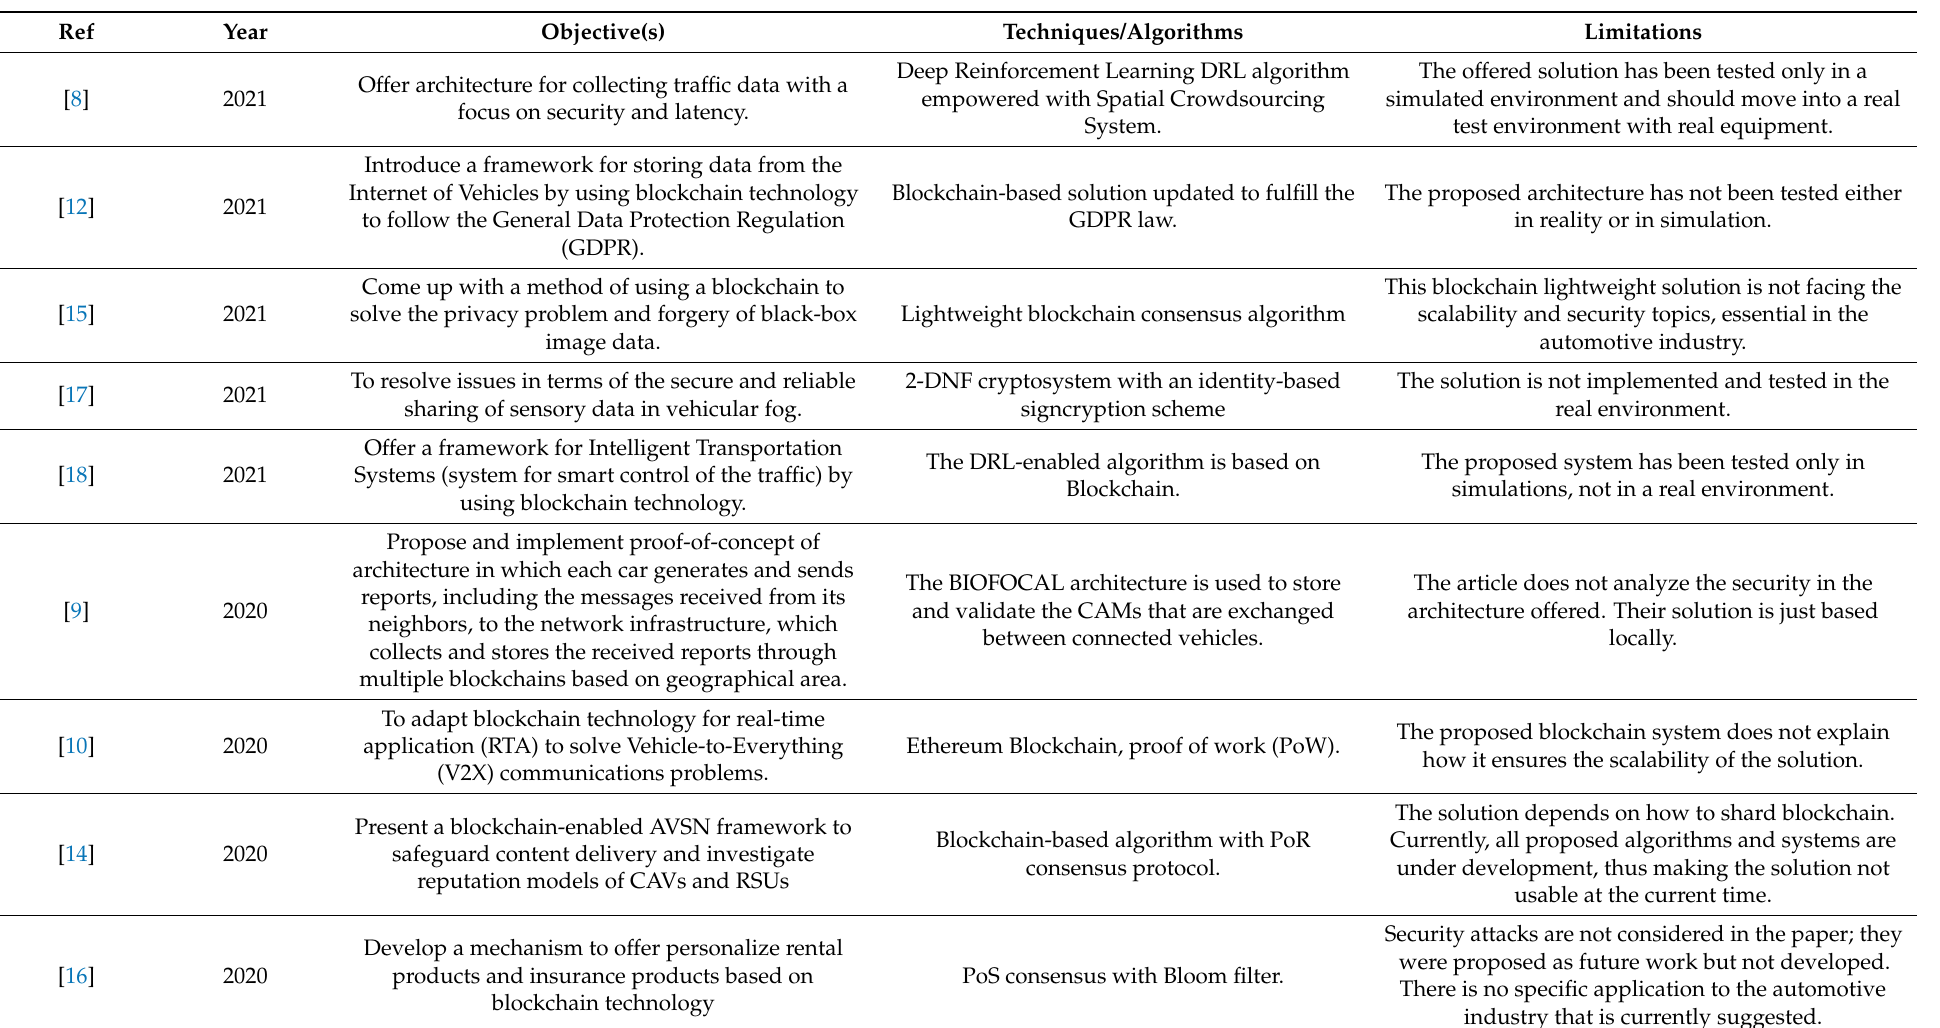
Table 1. List of relevant